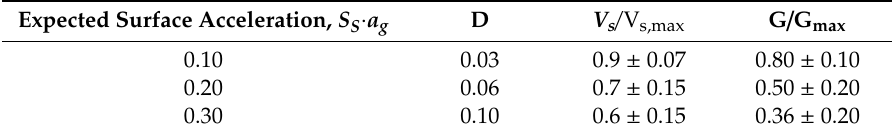
Table 3. Values of damping ratio ( D ) and degradation of V S and shear modulus ( G ; after [26]).